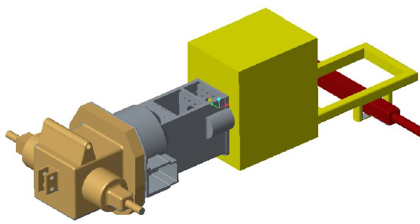
Figure 1. Transmission assembly diagram.